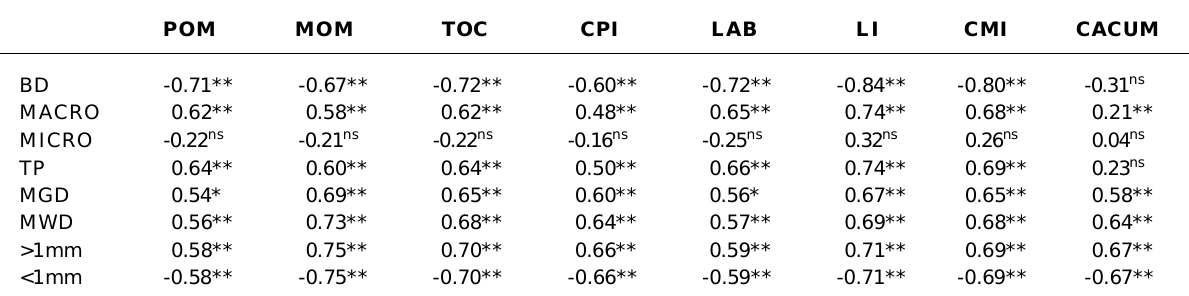
** and * significant by the t test at 1 % and 5 % respectively; ns, non-significant. BD: soil density; MACRO macroporosity; MICRO: microporosity, TP: total porosity; MGD: mean geometric diameter, MWD: mean weight diameter; > 1mm: aggregates larger than 1 mm; <1 mm: aggregates smaller than 1 mm; POM: particulate organic matter; MOM: mineral-associated organic-matter, TOC: total organic carbon; CPI: carbon pool index; LAB: lability, LI: lability index, CMI: carbon management index; CACUM: accumulated